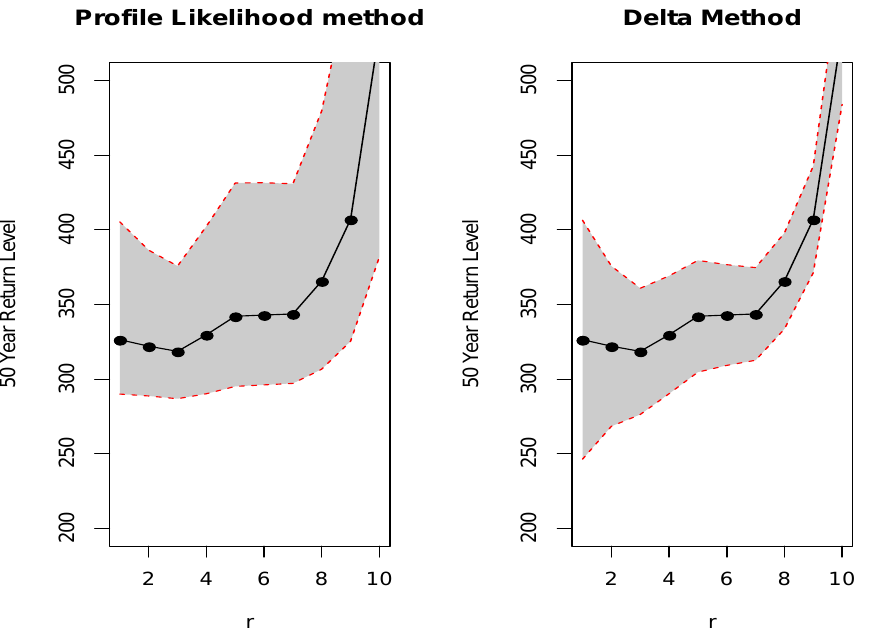
Figure 4. Return level plot using the profile likelihood and delta methods for determining best value of r =